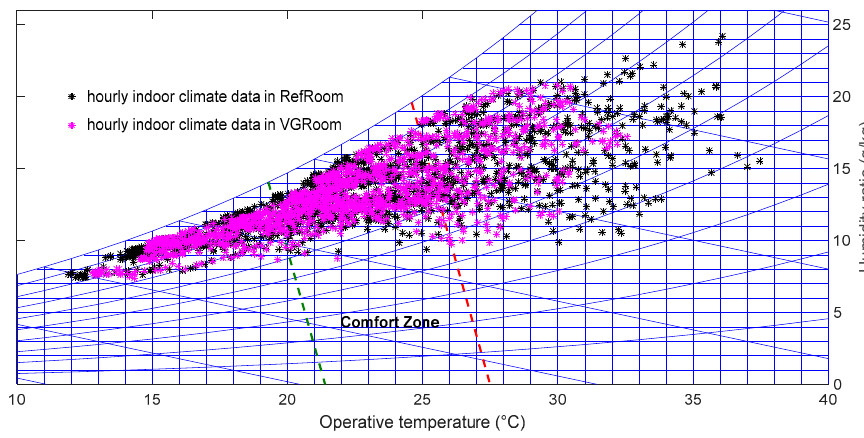
Figure 15. Hourly indoor climate data shown as a psychrometric chart of moist air.